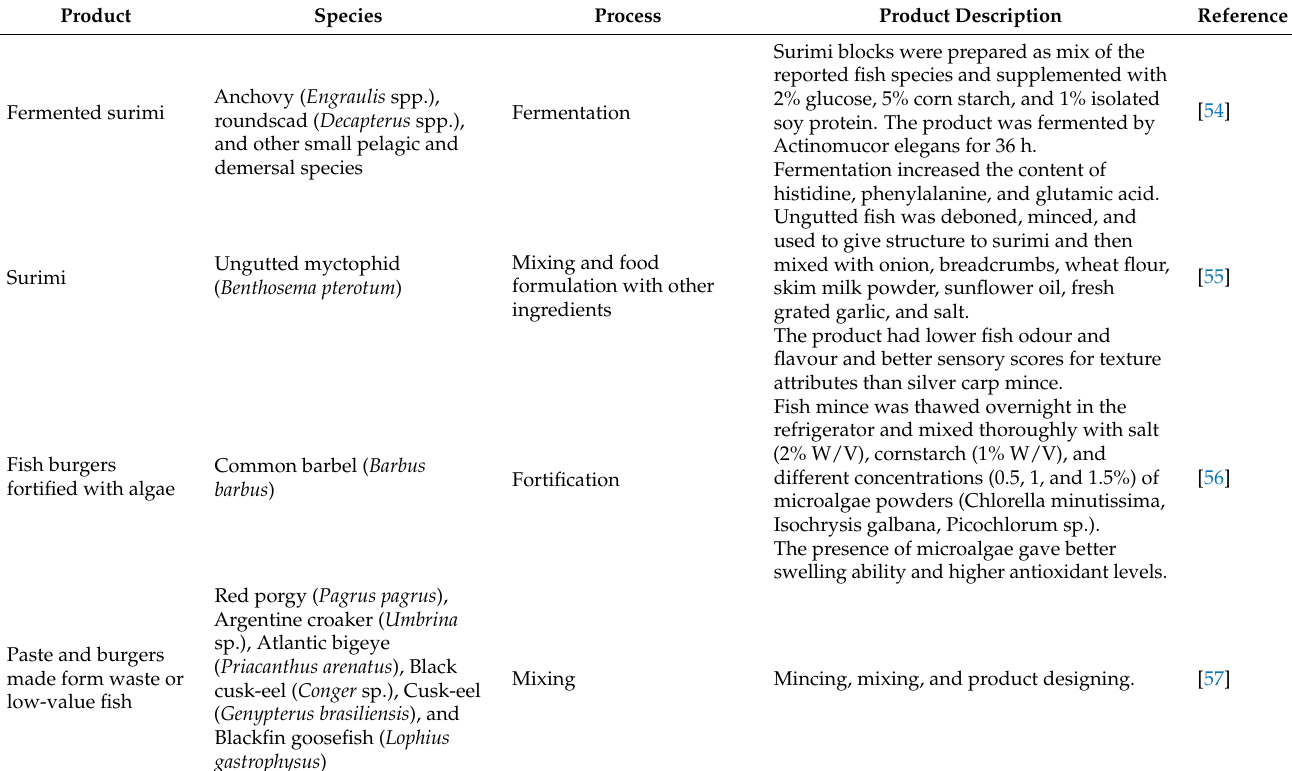
Table 4. Examples of new products from low-value or discard